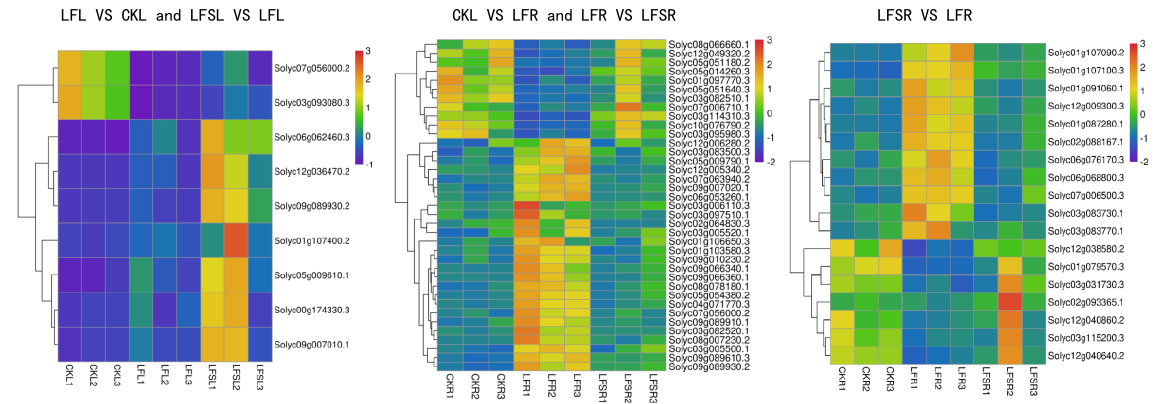
Figure 6. Heat map of differentially expressed genes related to plant hormone signal transduction and sucrose metabolism. Low Fe + Spd_Root sample vs. Low Fe_Root sample.